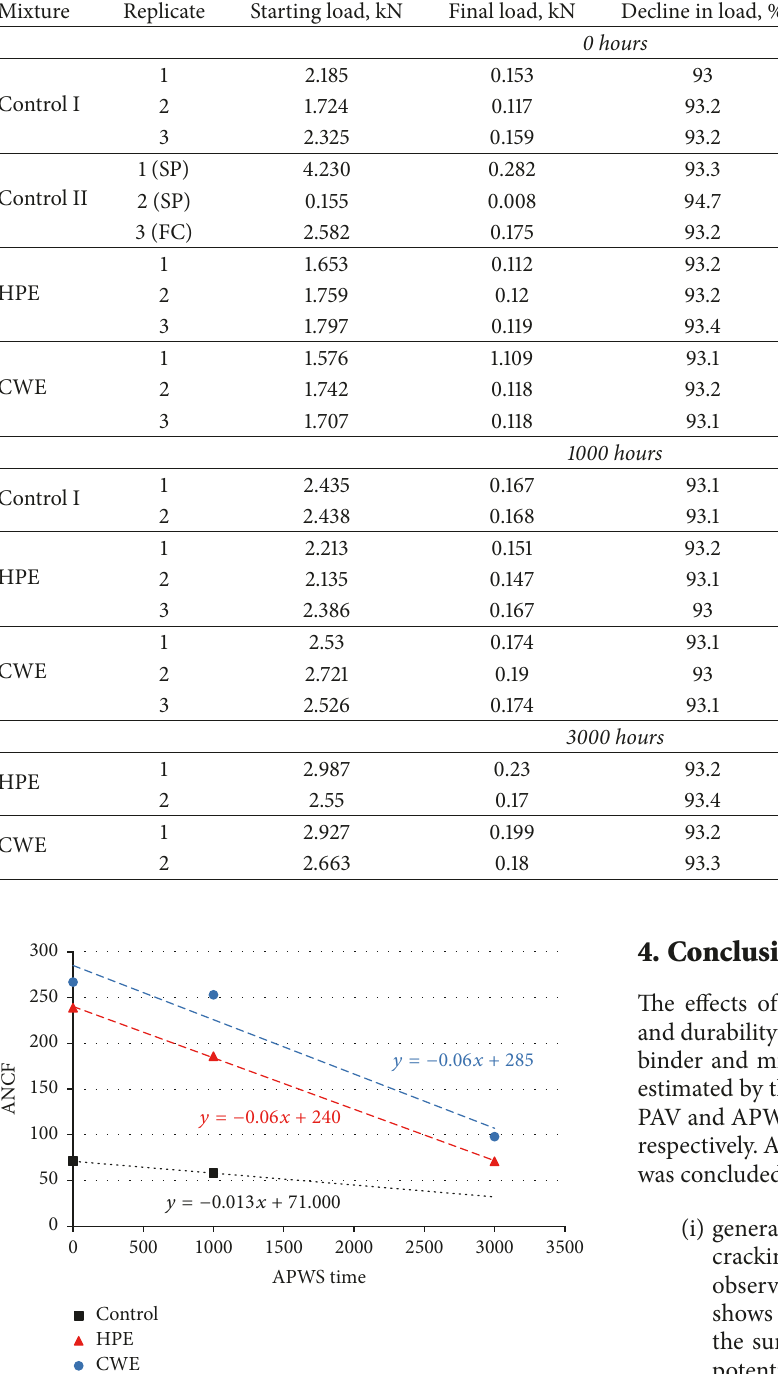
Figure 4: Variations of the average number of cycles to failure with APWS aging